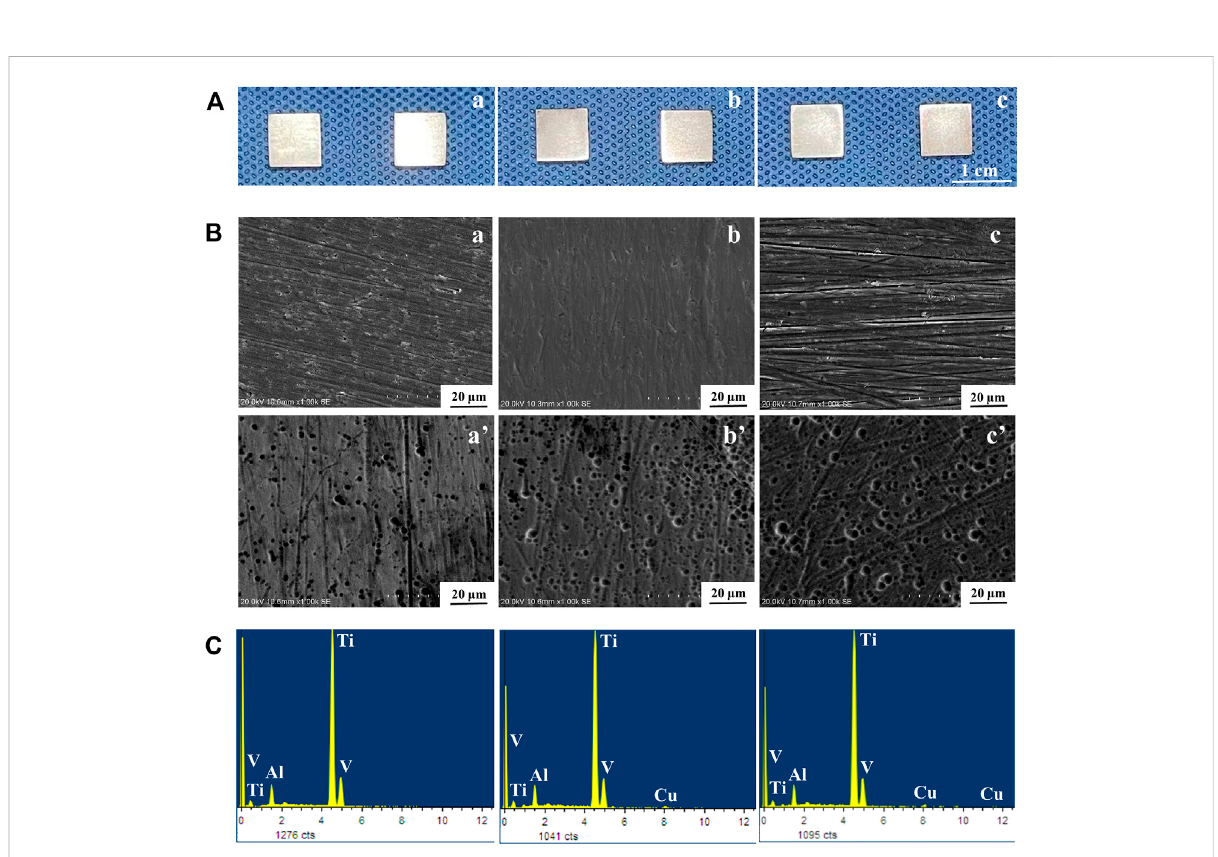
FIGURE 2 Surface morphology of alloys: (A) macro images of alloys; (B) SEM images of alloys; (C) EDS analyses of alloys: (A) TC4 alloy and (a ’ ) ETC4 alloy; (B) TC4-5Cu alloy and (b ’ ) ETC4-5Cu alloy; (C) TC4-6Cu alloy and (c ’ ) ETC4-6Cu